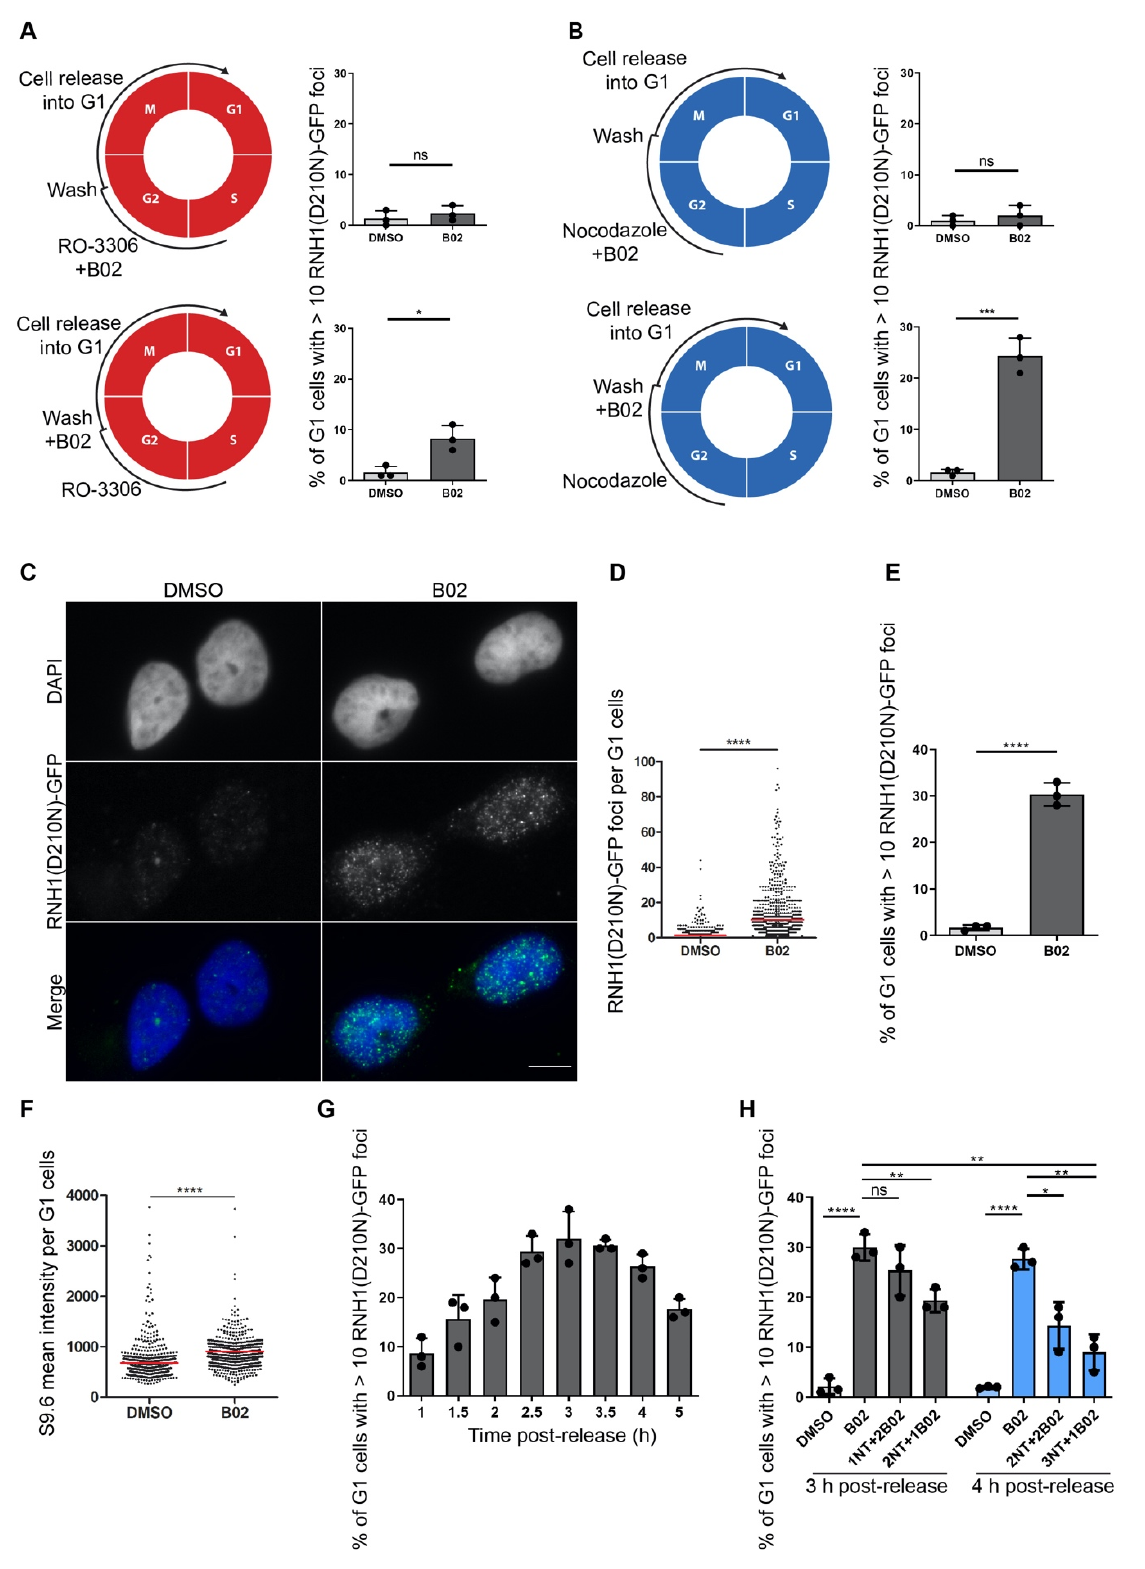
Figure 2. RAD51 inhibitor B02 induces the formation of R-loops in the early G1 phase of the cell cycle. ( A , B ) U-2-OS T-REx (RNH1(D210N)-GFP) cells were synchronized in the G2 or prometaphases with RO-3306 (9 µM, 16 h) and nocodazole (100 ng/mL, 20 h), respectively. B02 was added for the last 6 h of treatment with synchronization agents (top panel) or after the cells were released from cell cycle arrest (bottom panel) for 3 h (nocodazole) or 4 h (RO-3306). Doxycycline (1 ng/ mL) was present for 24 h. Schematic representations of the protocol alongside the quantification of fraction of G1 cells with more than 10 RNH1(D210N)-GFP foci are shown for RO-3306-treated cells in ( A ) and nocodazole-treated cells in ( B ).